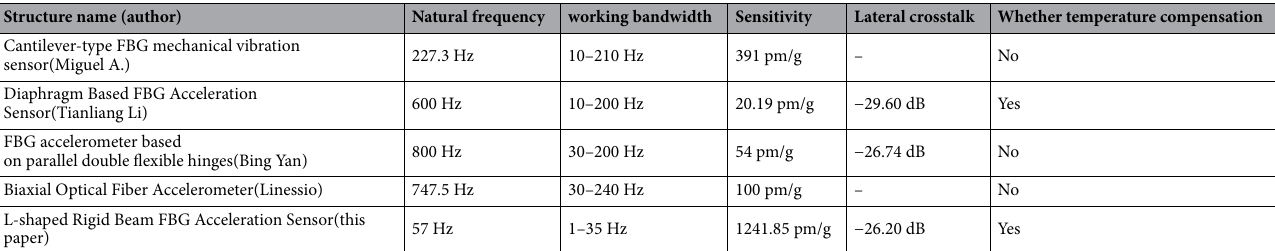
Table 3. Structural parameters of the